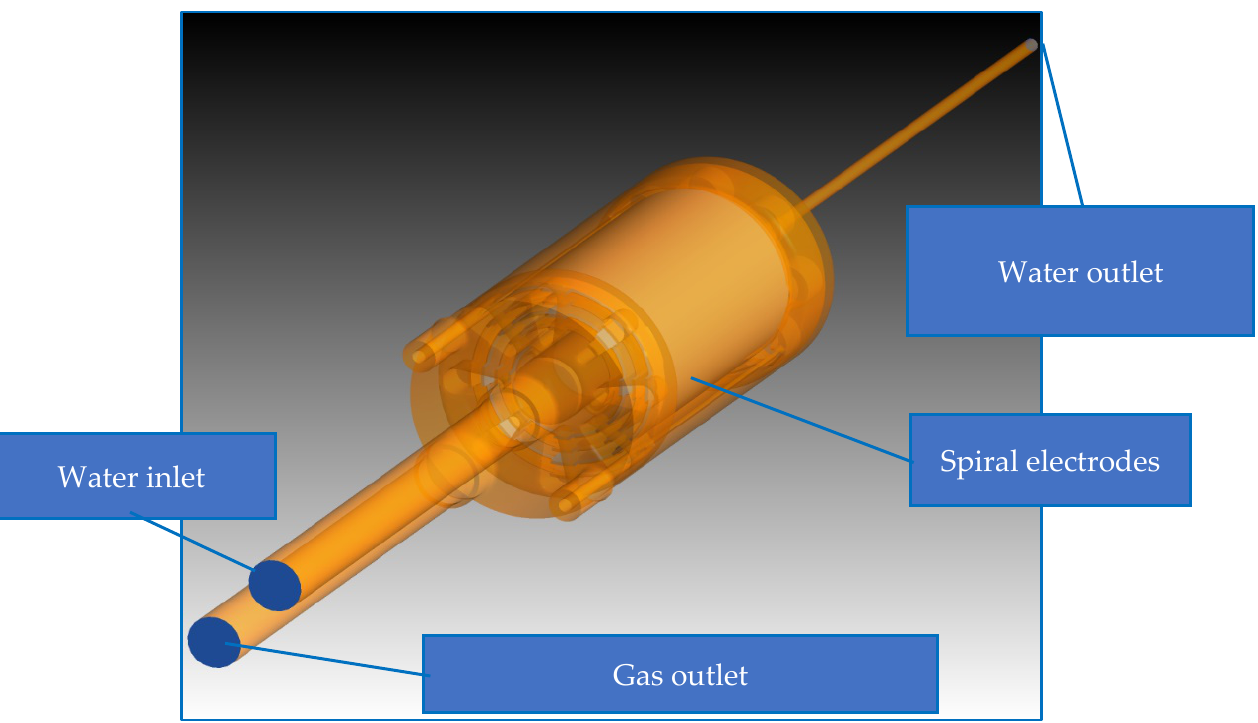
Figure 4. Boundary conditions of the EC-reactor with water inlet, water outlet, spiral cathode, and gas outlet.